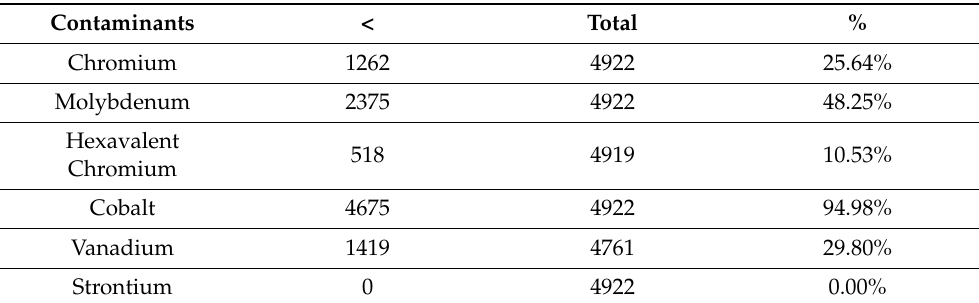
Table 1. The number of all water systems that reported all concentration values below the MRL (<) is listed for each of the six